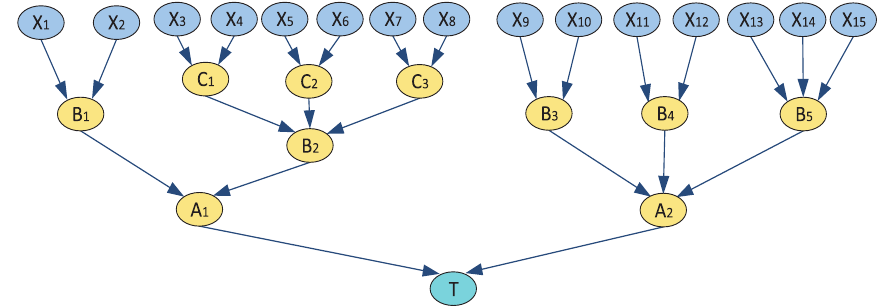
Fig. 6. BN model of electro-mechanical braking system. 1